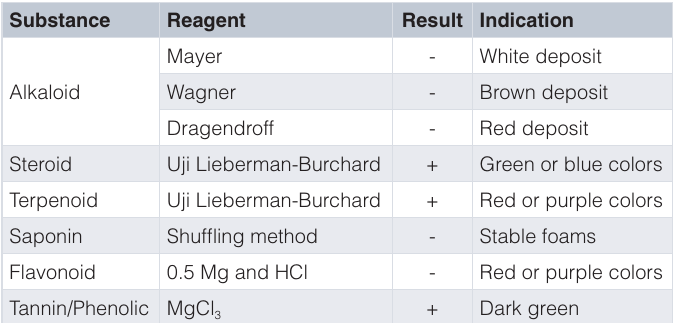
Table 1. Phytochemical contents of seaweed Gracilaria verrucosa